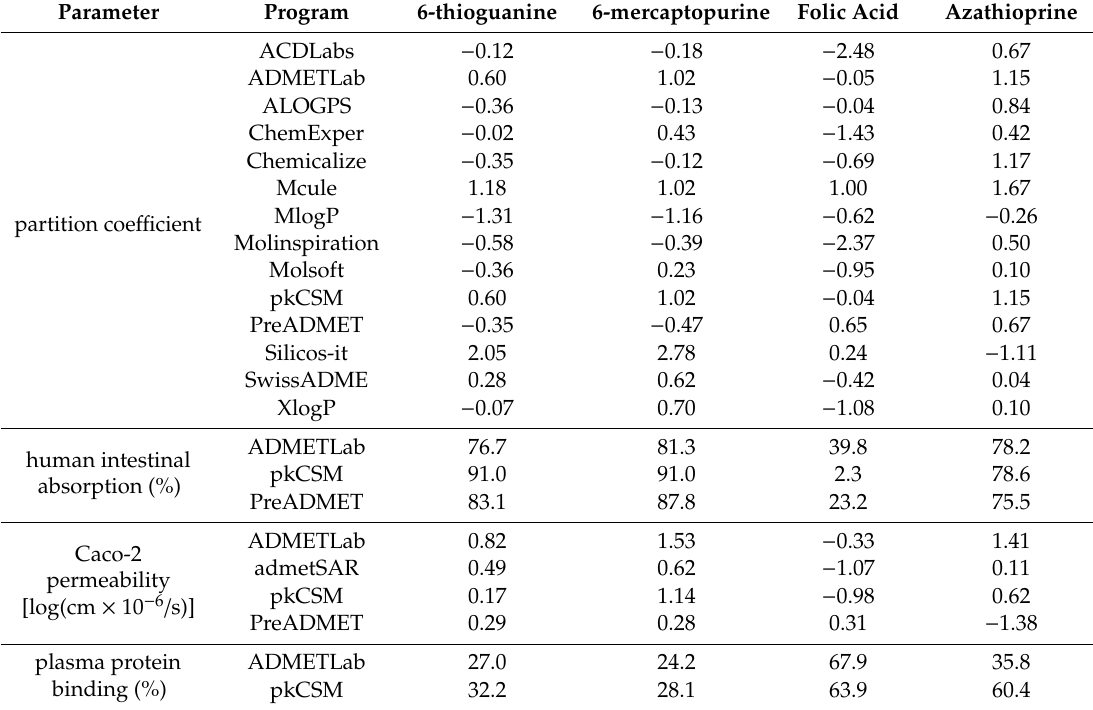
Table 2. List of calculated physico-chemical and pharmacokinetic